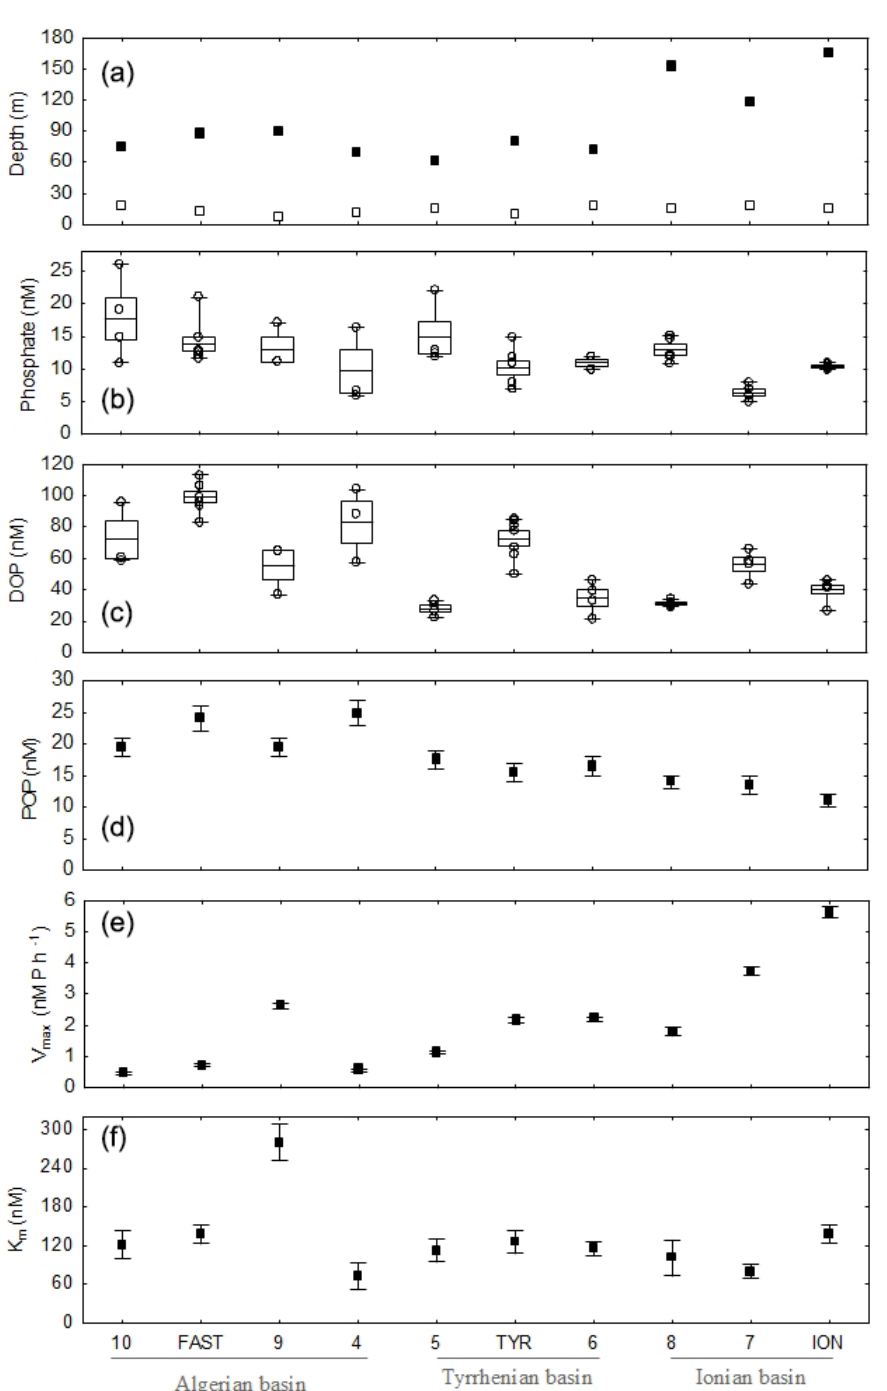
Figure 2. Depth of the mixed layer (empty symbols) and the phosphacline (filled symbols; see Sect. 2.5 for details on the calculations) across the transect (a) . Longitudinal variability inside the phosphate-depleted layer of phosphate concentration (b) , DOP concentration (c) , particulate organic phosphorus (d) , and AP Michaelis–Menten parameters V max and K m (e,f) . Phosphate and DOP data are represented as box plots (average, standard error and min–max values inside the PDL) as well as raw data (empty symbols). For POP, V max and K m , data shown were measured at 5m depth, and error bars correspond to measurement precision (POP) and fitting model standard errors ( V max and K m